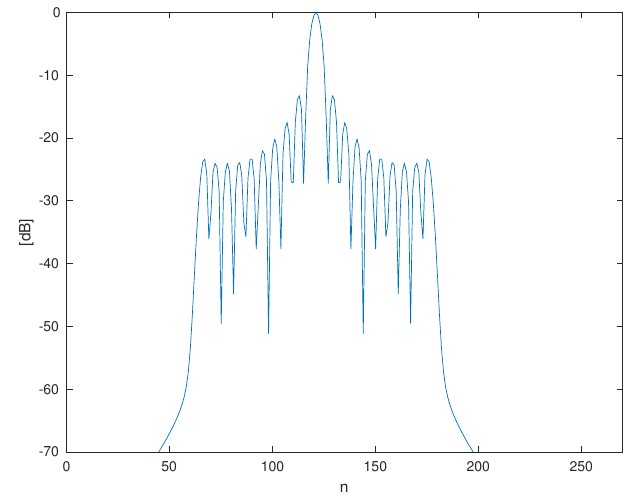
Figure 5. Amplitude of the spectrum of the near field along the observation line; since the support of the spectrum is concentrated in the “visible range” interval, the field is an essentially bandlimited function.